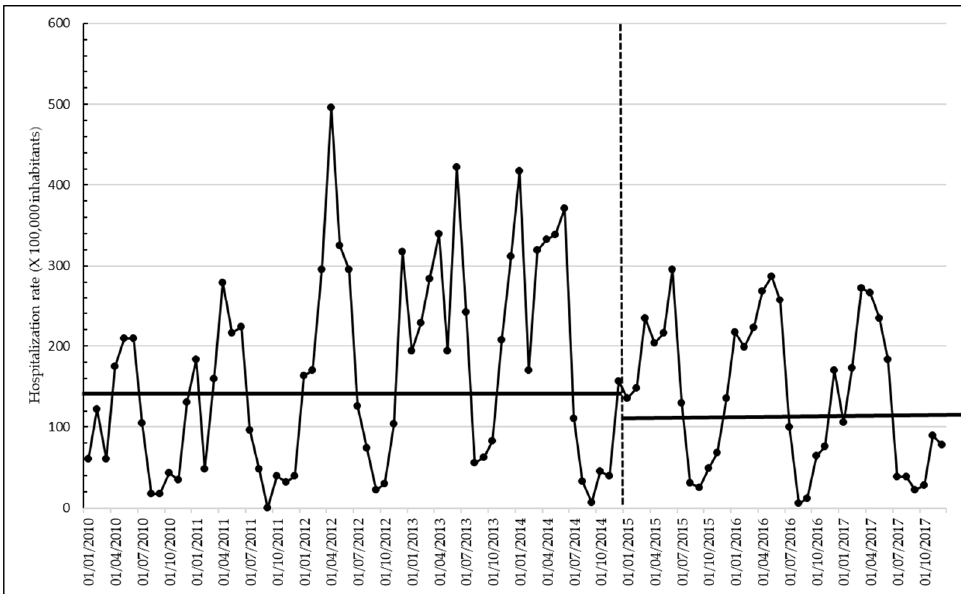
Figure 3. Monthly hospitalization rates of varicella in Ligurian subjects aged 0–17 years old, study period 2010–2017.